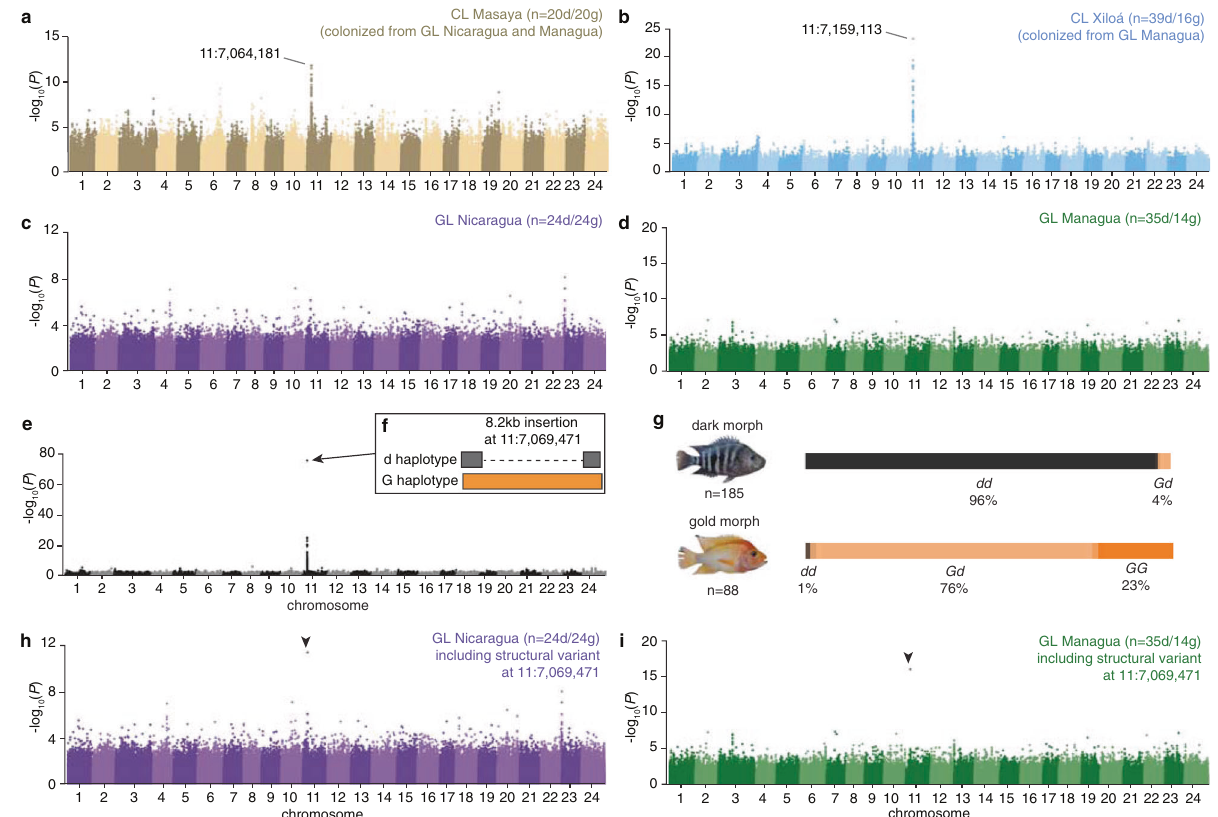
Fig. 1 Genotype – phenotype mapping of the gold/dark polymorphism. a – d Genome-wide association mapping for the gold/dark polymorphism in Midas cichlids using previous genotype data 5 reveals a prominent peak on chromosome 11 in CLs Masaya ( a ) and Xiloá ( b ) but not in the source populations from GL Nicaragua ( c ) and GL Managua ( d ). e, f The inclusion ( e ) of a newly discovered structural variant ( f ) in cross-population genome-wide association mapping ( e ) provides strong support that this variant constitutes the genetic basis of the phenotype (LRT test, P = 2.23 × 10 − 76 ). g Compatible with the dominant Mendelian inheritance pattern, individuals with one or two G alleles are gold, individuals with two d alleles are dark. Only 4% of dark individuals had the Gd genotype ( n = 8), and likely represent phenotypically dark but yet untransformed genetically gold individuals (note that Gd individuals transform much later than GGs 5 ). Among the golden individuals, we only found a single phenocopy that was gold but lacked the G allele (out of n = 88). Genotype distribution by morph and species/population is shown in Supplementary Fig. 1. h, i The analysis of the newly discovered structural variant ( f ) also reveals a much clearer association of this speci fi c variant (arrowhead) with the phenotype in the two source populations from GL Nicaragua ( h ) GL Managua ( i